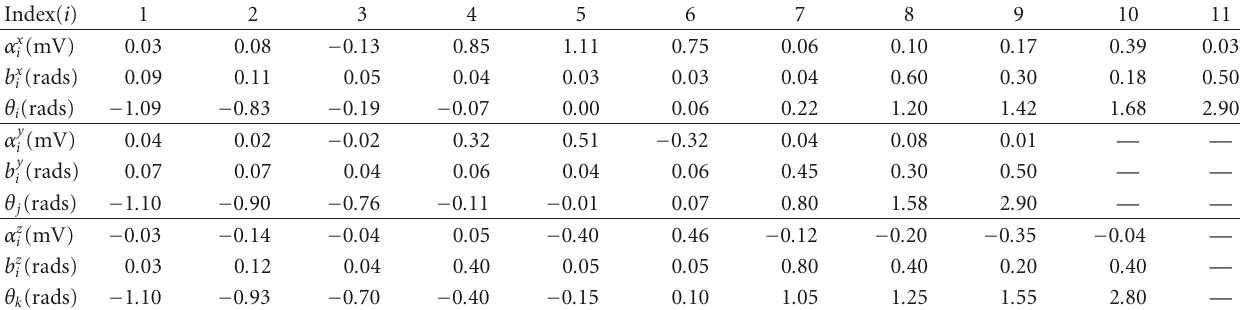
Table 1: Parameters of the synthetic model presented in (4) for the ECGs and VCG plotted in Figures 2 and